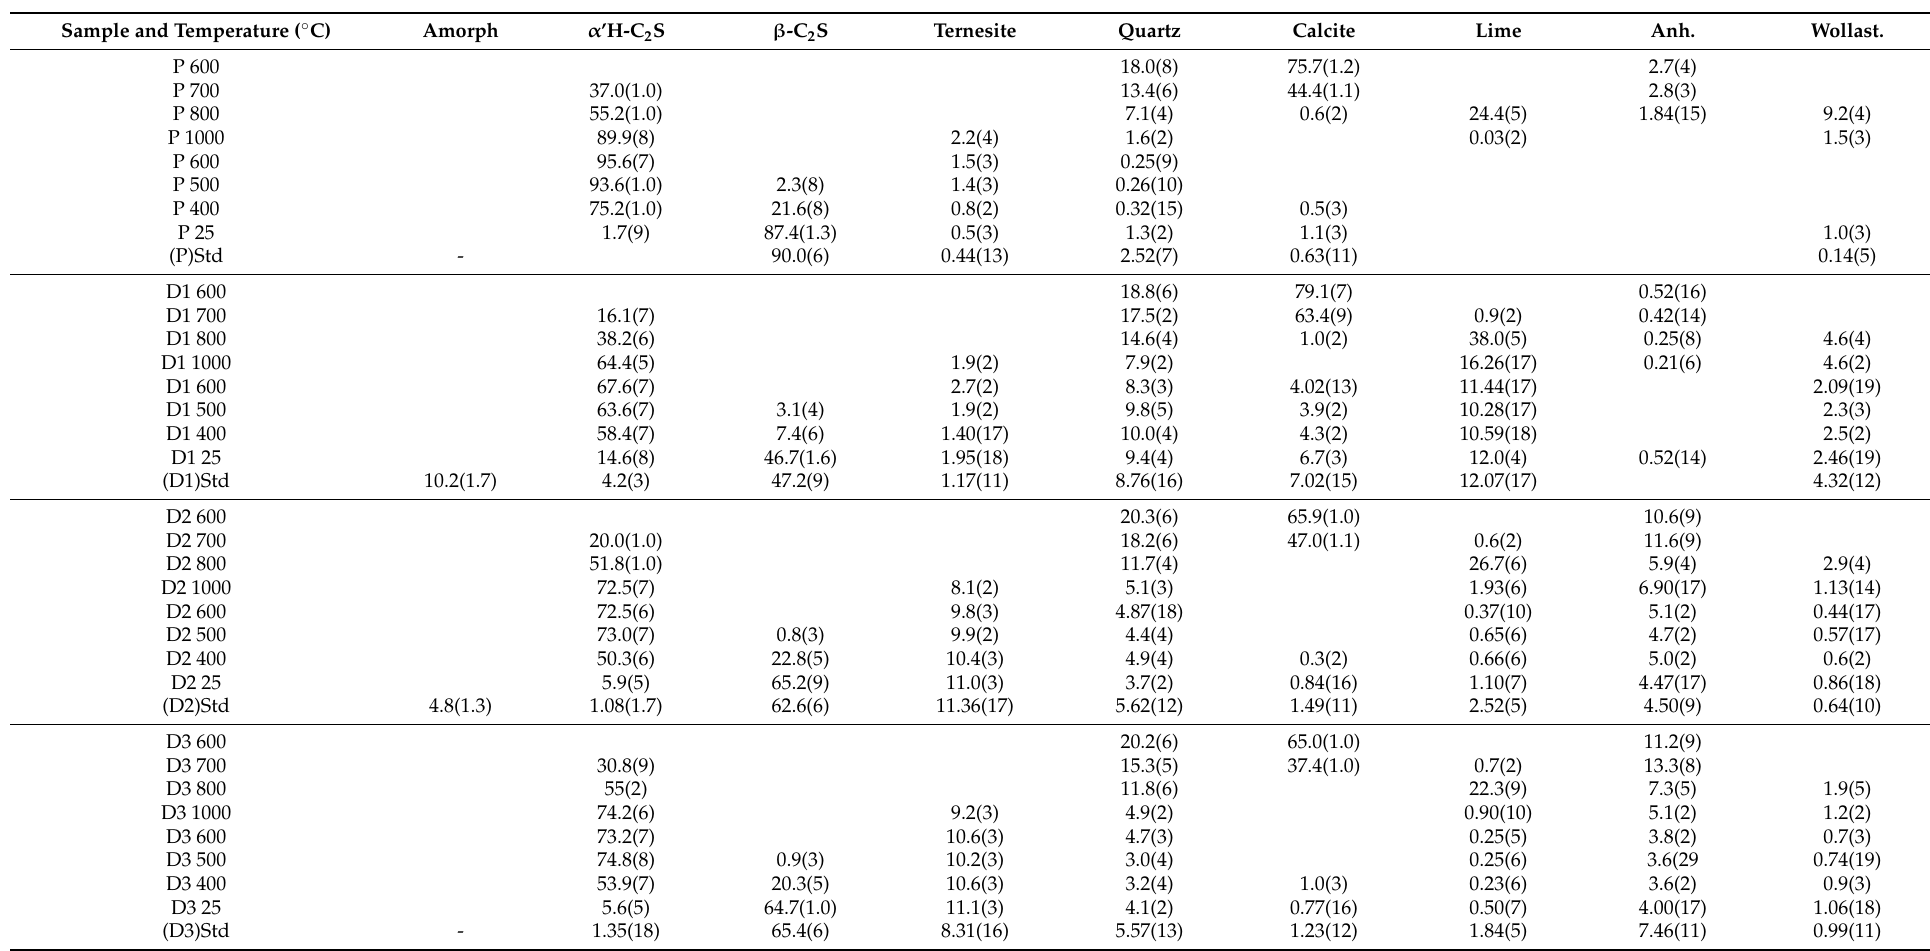
Table 4. Selected crystalline phase contents determined in situ and quantitative analysis with standard at room temperature (Std). Anh. = anhydrite and Wollast. = wollastonite. Additional minor phase contents in all samples are <4 wt.% spurrite and gehlenite, <3 wt.% browmillerite and microcline, <2 wt.% ye’elimite, åkermanite, and albite. D3_step10: experiment with slow heating rate (additional 5.3(4) and 8.6(4) wt.% åkermanite-gehlenite at 950 ◦ C and 25 ◦ C, respectively). D3_2.5: experiment with C/S-ratio of 2.5. Sample and Temperature ( ◦ C) Anh.